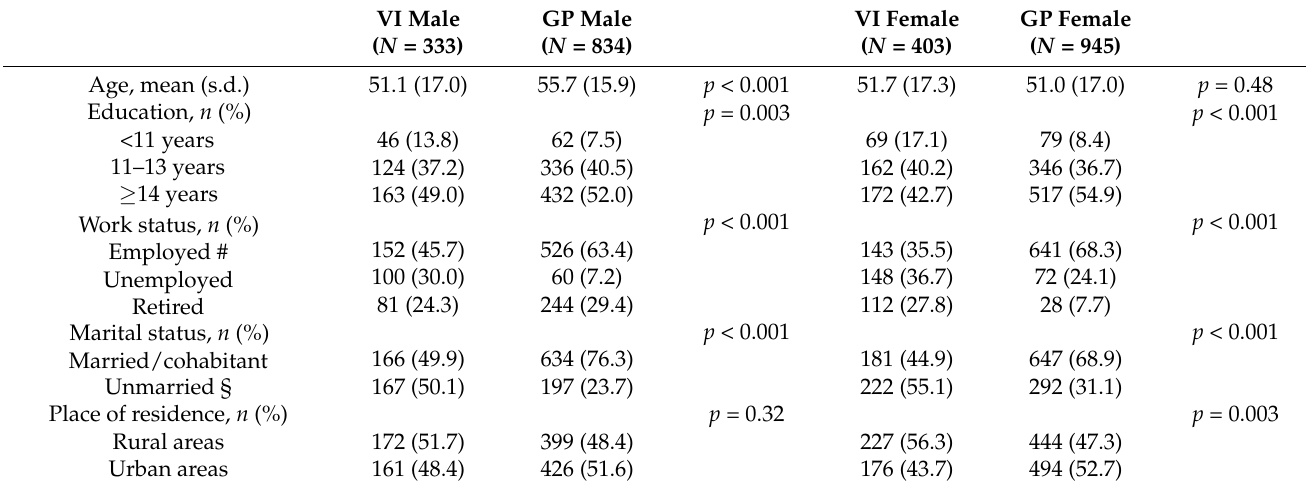
Table 1. Study characteristics of males and females from the visual impairment population ( N = 736) and the general population ( N =